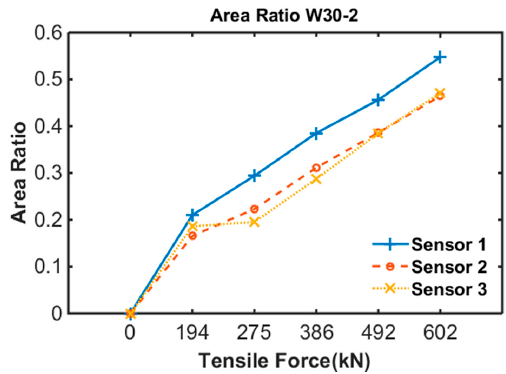
Figure 12 . Area ratio of specimen 2 .